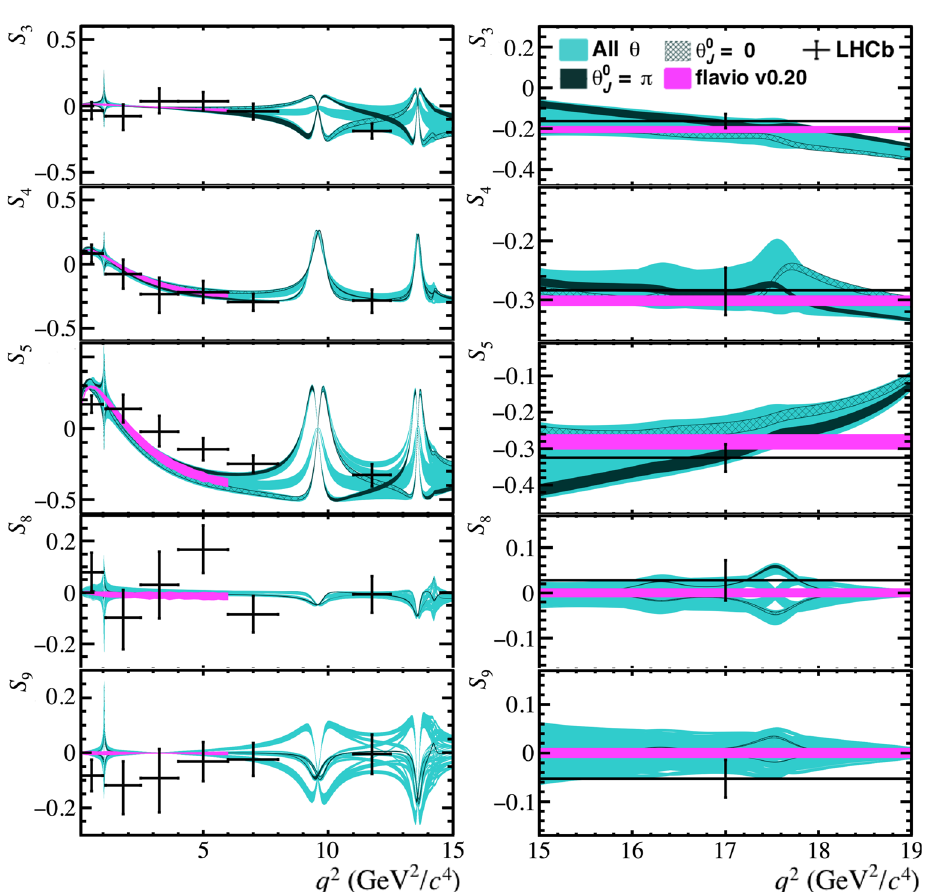
= π (dark band). The measured values of the observables from θ 0 j = 0 (hatched band) and j